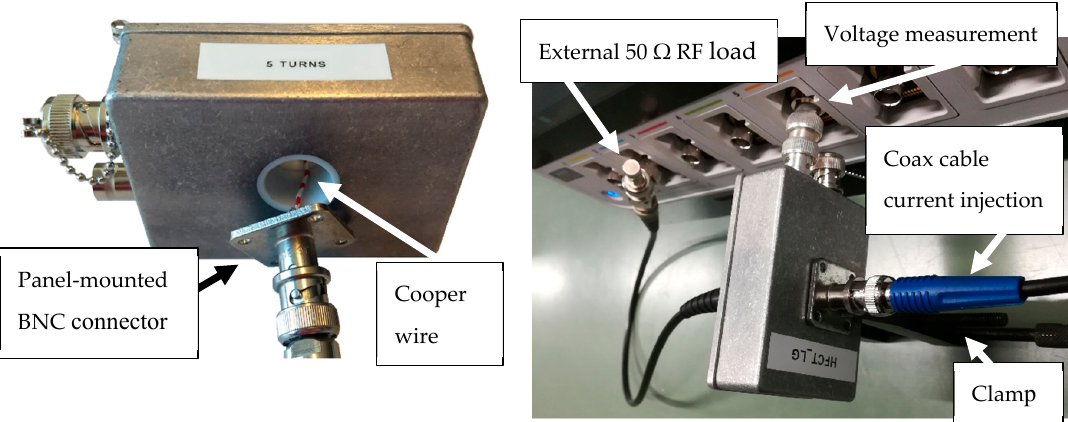
Figure 11. HFCT testing setup and sensor connection to the oscilloscope.